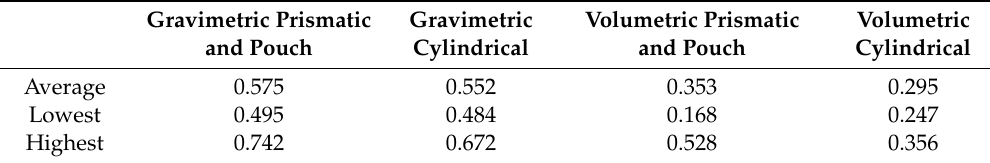
Table 1. E ffi ciency rate of cell level to system level.